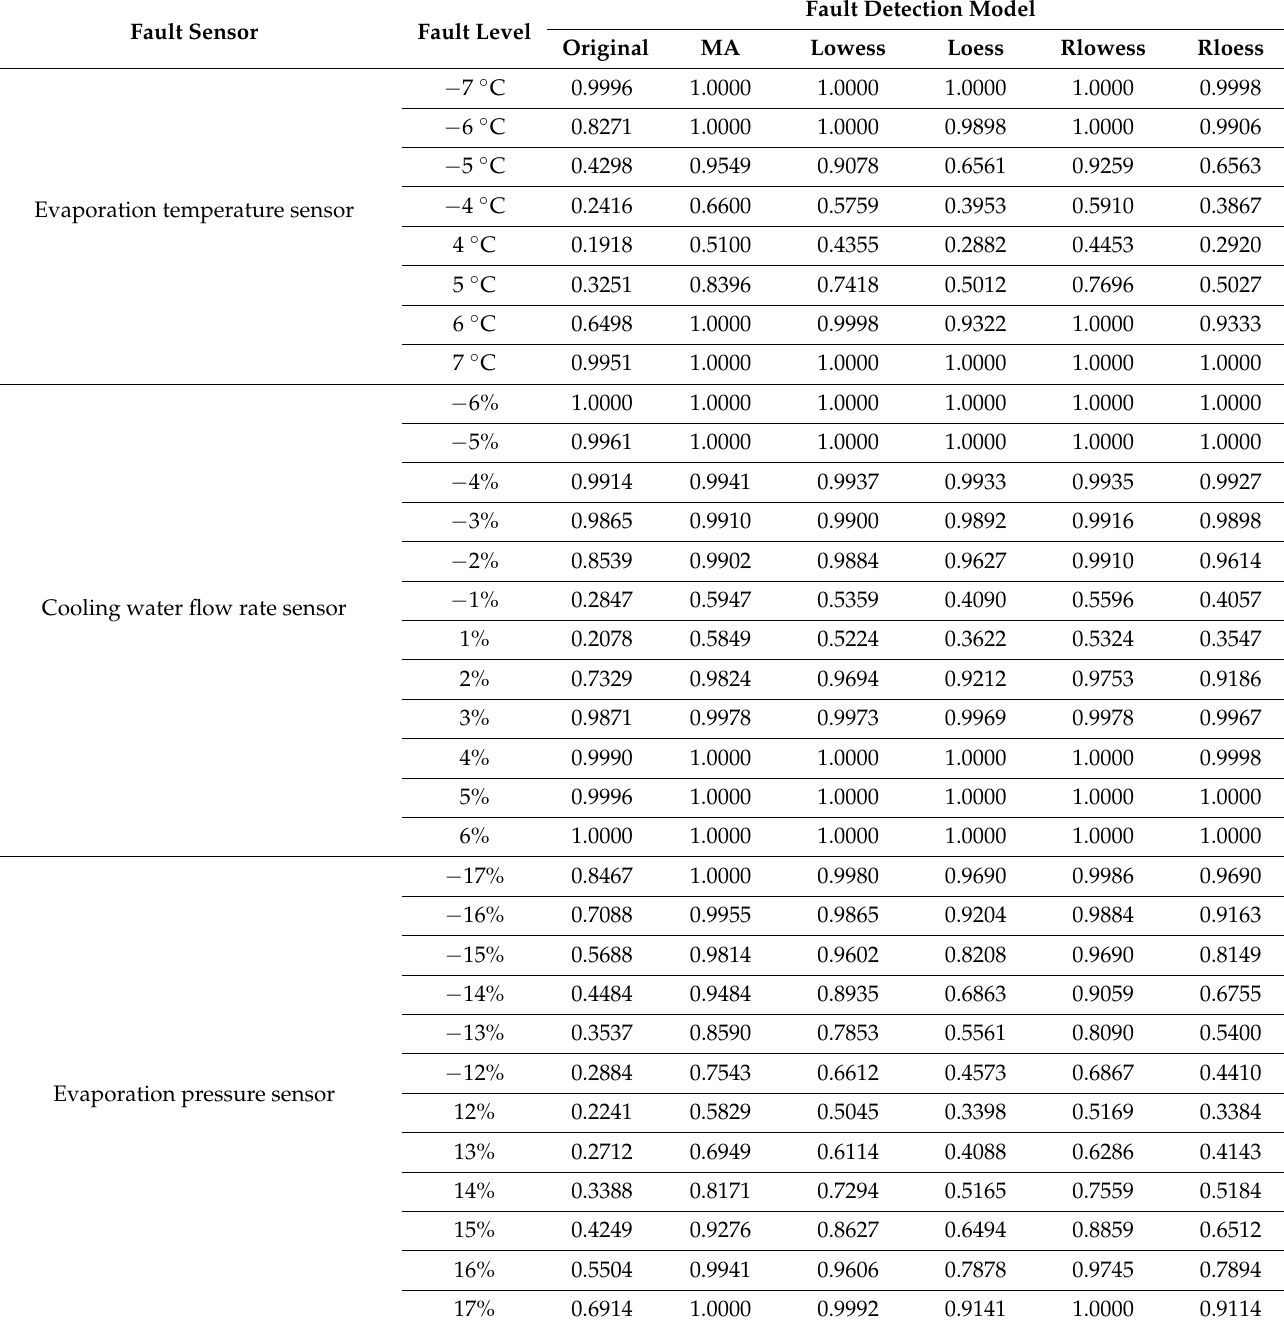
Table 3. Fault detection results of different types of